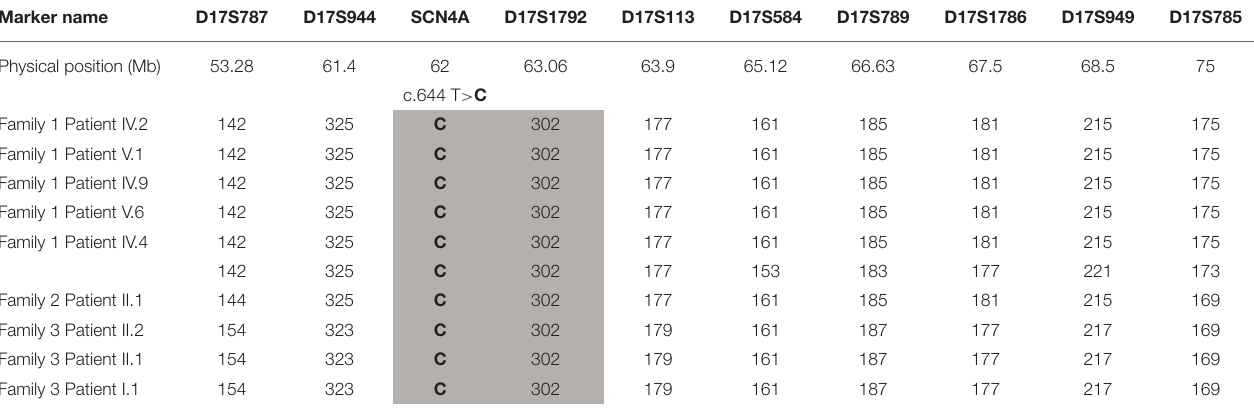
TABLE 2 | Microsatellite analysis showing haplotypes for five families carrying the p.Ile215Thr.